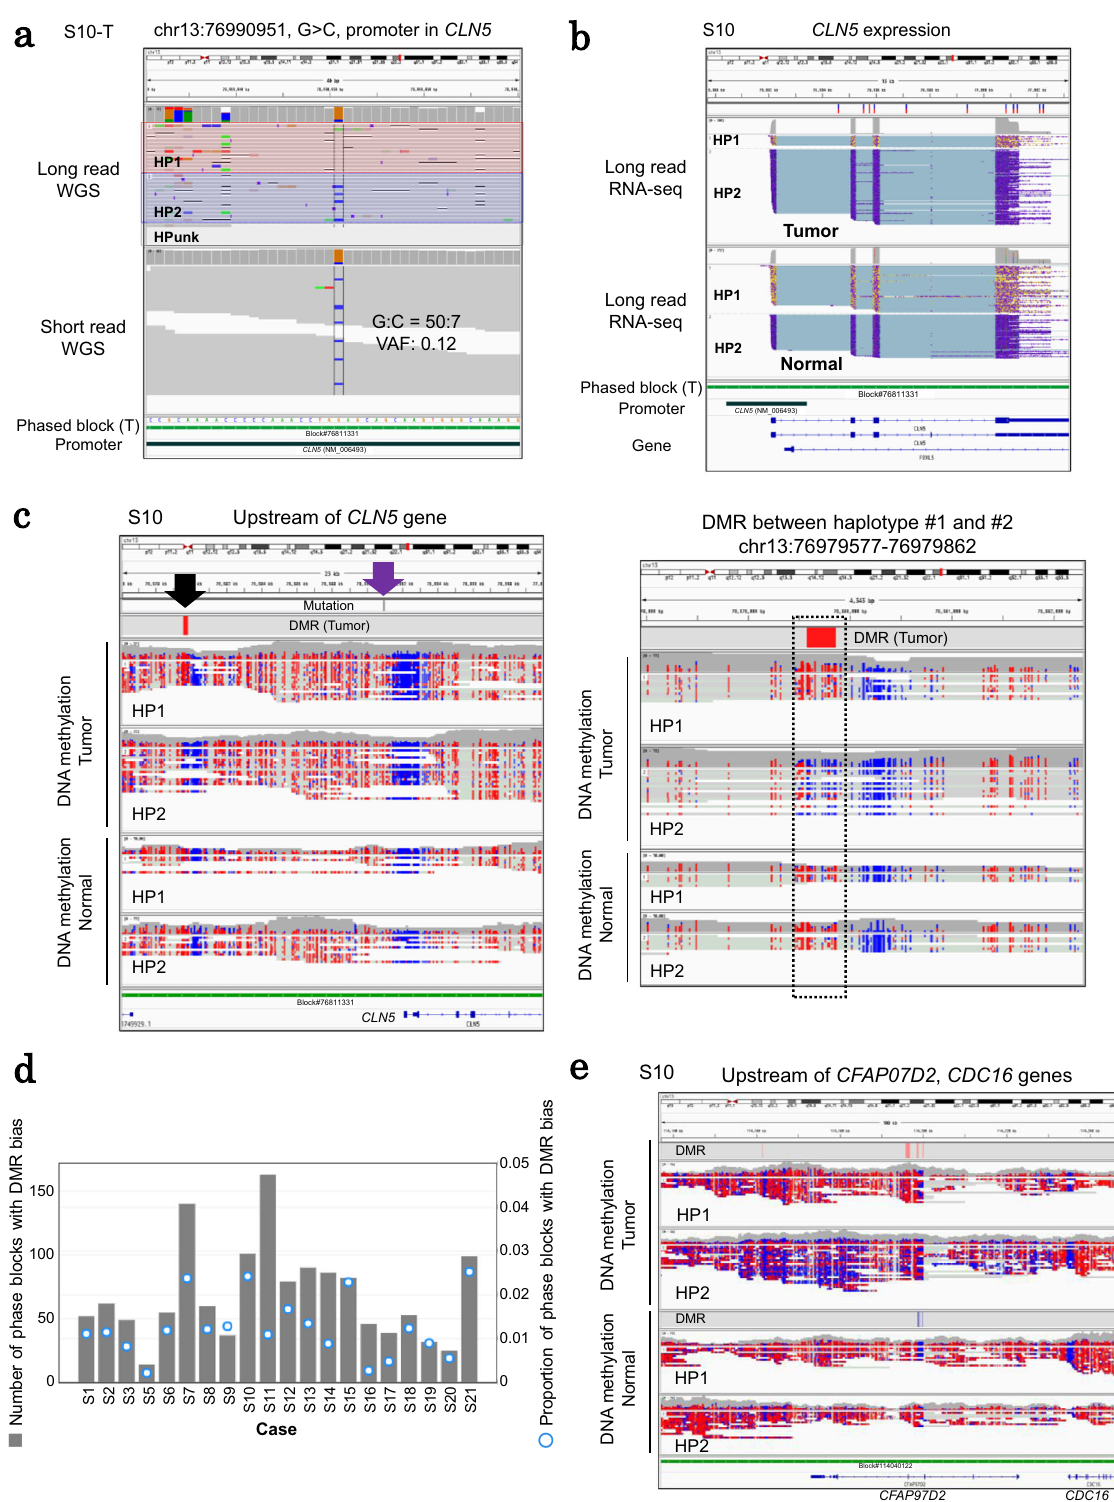
chromosomal events accompanying the mutation-enriched blocks may have caused further mutational events, increasing TMB. Among them, 190 regions (1 – 75 region(s) per case) were identi fi ed to harbor more than 80% of the mutations pre- ferentially in one of the haplotypes (designated as “ haplotype- biased ” regions; Fig.